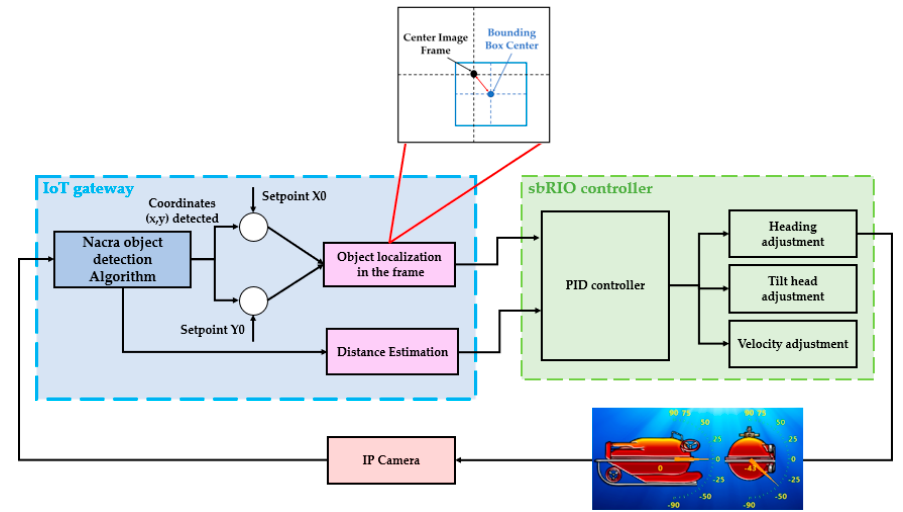
Figure 10. Closed control loop for object detection and tracking.